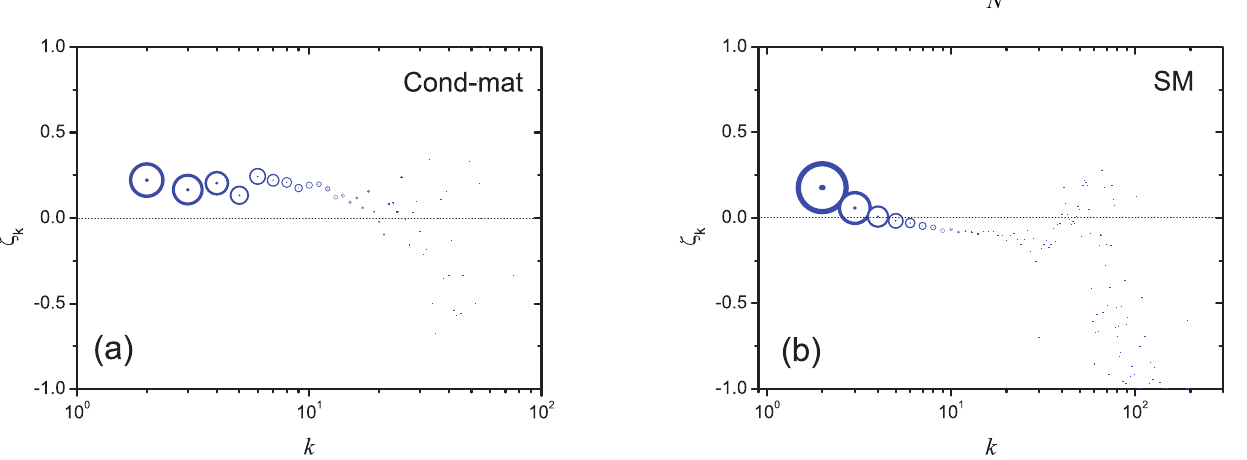
Figure 1. The correlation between f k and the degree in the first network k . The area of a circle is proportional to the number of nodes with the corresponding